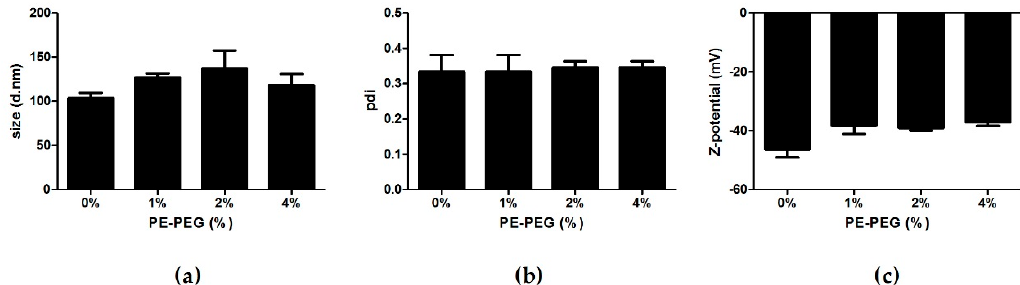
Figure 1. Particle size, polydispersity index and ζ -potential values of solid lipid nanoparticles (SLN) coated with different percentage of phosphatidylethanolamine polyethylene glycol (PE–PEG). ( a ) Particle size, ( b ) polydispersity index (pdi) and ( c ) ζ -potential values of different SLN were obtained by Photon Correlation Spectroscopy. Results are the mean ± SEM of four independent experiments.